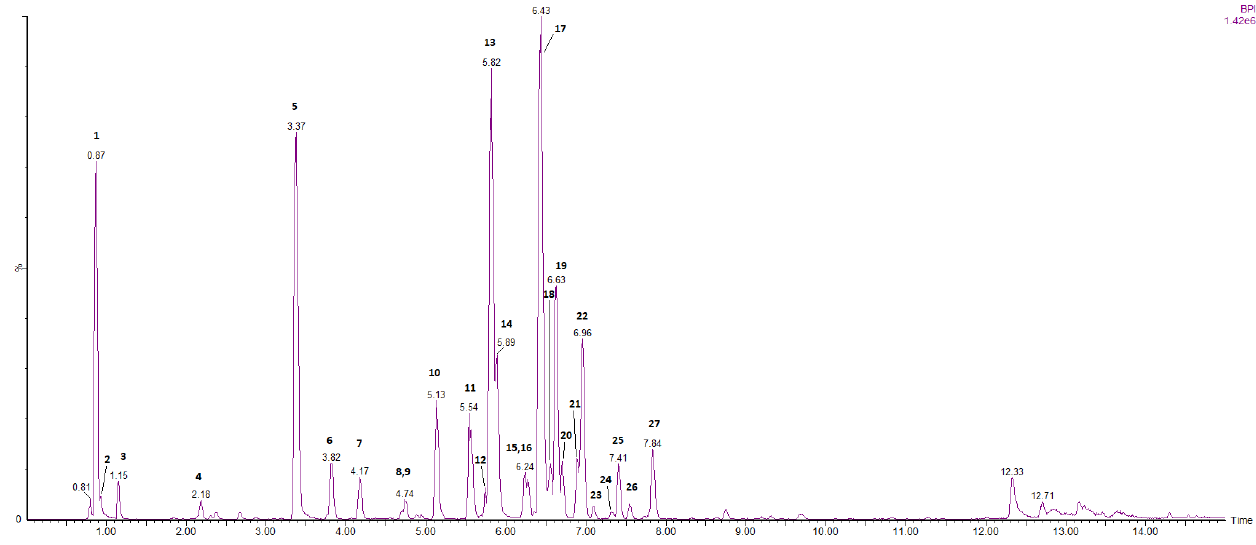
Figure 1. Base peak chromatogram of L. alpinum callus cultures’ methanolic extract. Peak numbers correspond to the compounds from Table 1. Table 1. Compound identifications obtained after LC-IM-MS analysis of L. alpinum callus